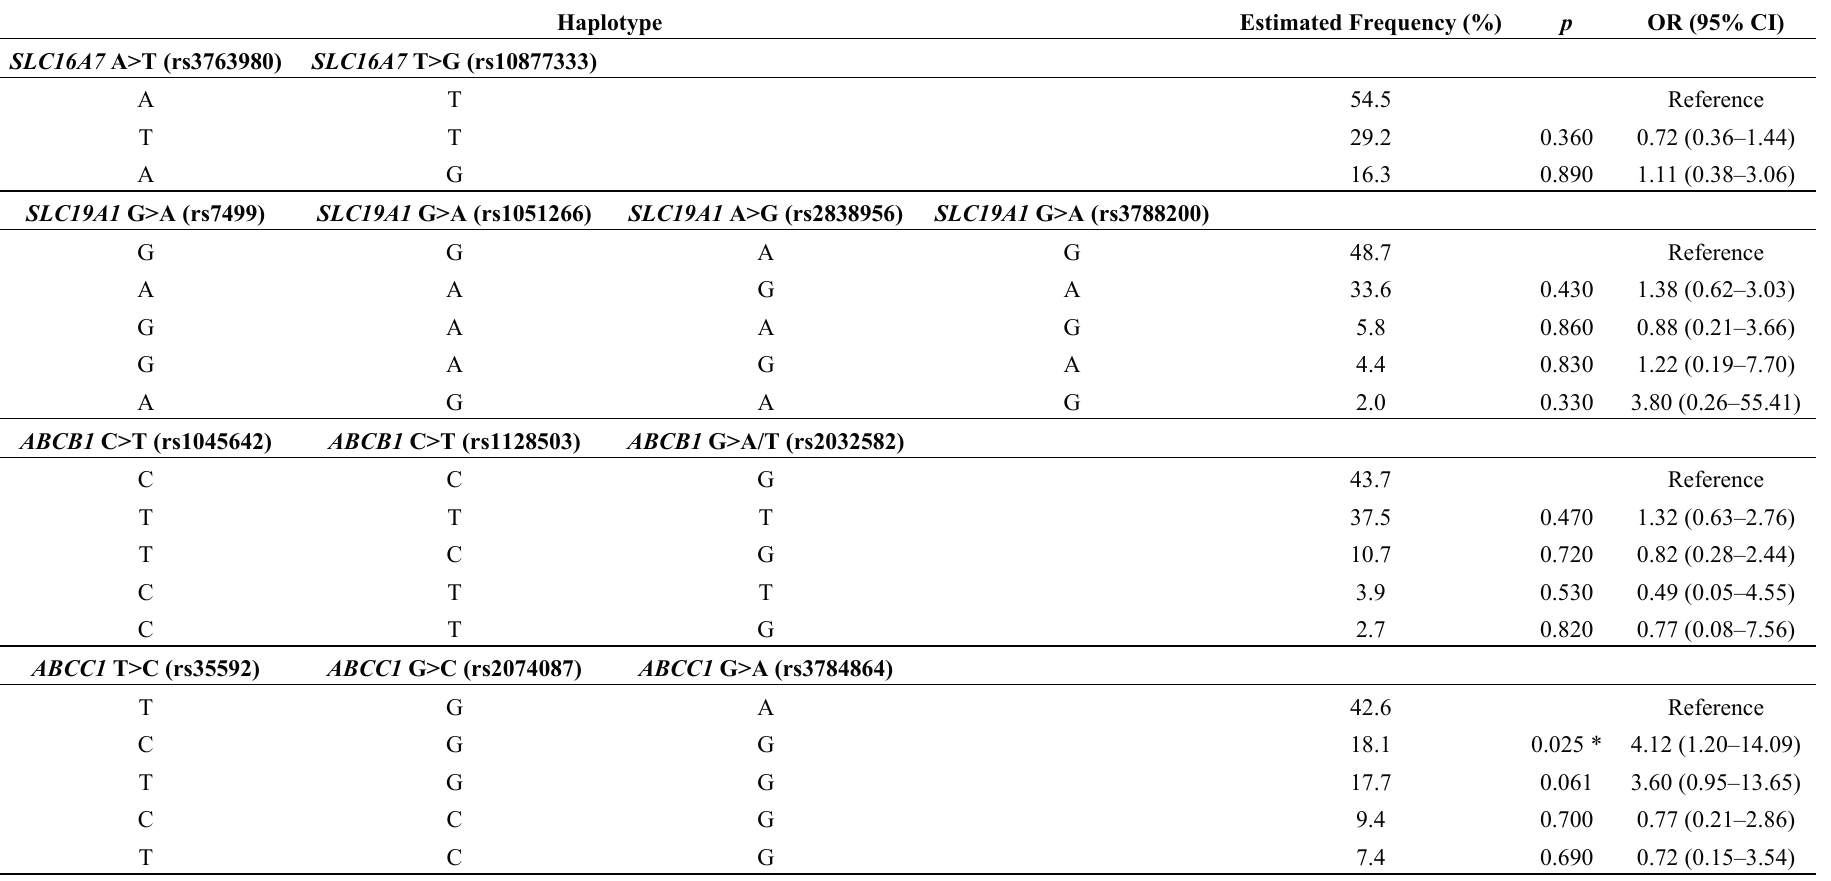
Table 2. Relation between MTX transporters genes haplotypes and clinical response to